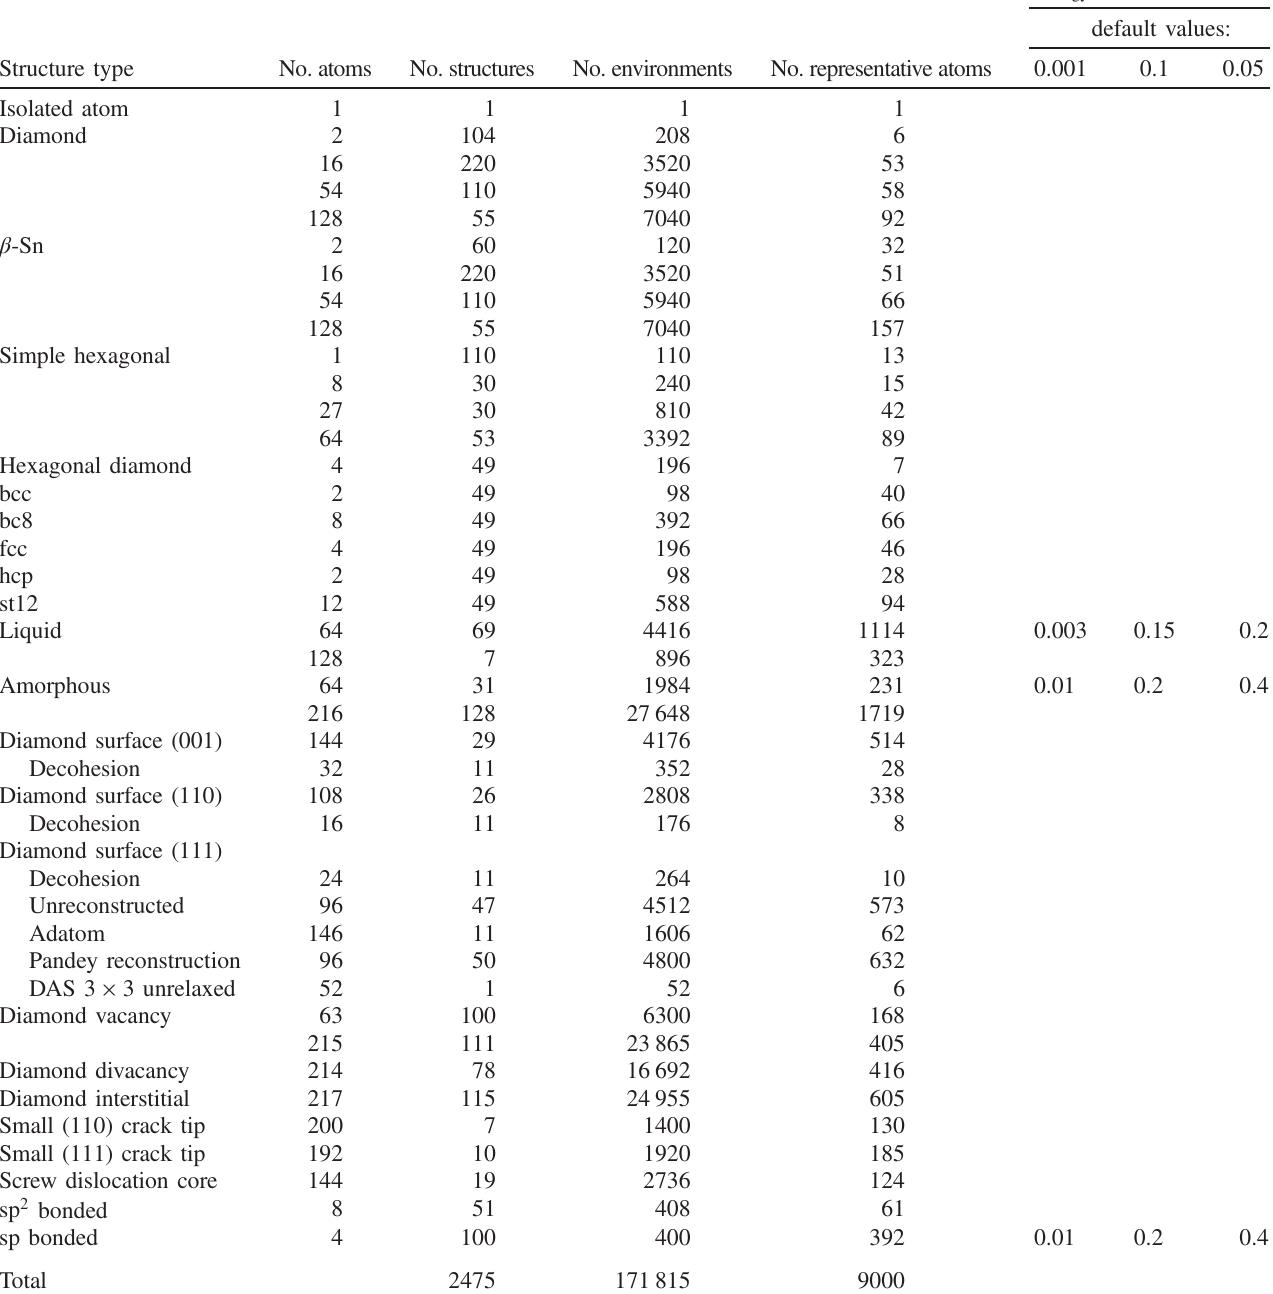
TABLE I. Summary of the database for the silicon model. The first column shows the number of atoms in the periodic unit cells, and the second column shows the number of such unit cells in the database, while the third column is the product of the first two and, thus, shows the number of atoms (and, therefore, atomic environments) in the database for each structure type. The fourth column shows the number of representative atoms picked automatically from each structure type by the CUR algorithm (see the text). The last three columns show the regularization we use in the linear system (empty rows correspond to using the defaults, given at the